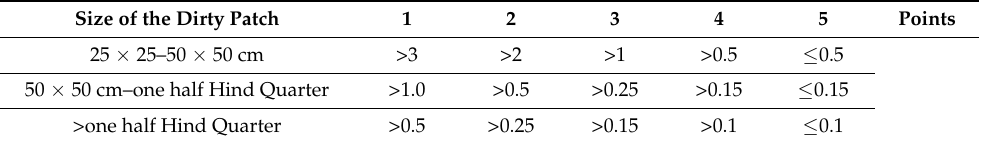
Table 2. Clinical scoring for the dirtiness of the